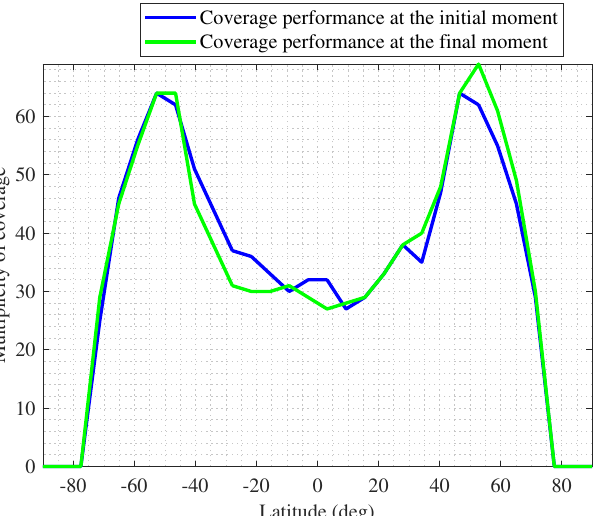
Figure 28. Multiplicity of coverage of the GW-2 sub-constellation at the initial and final